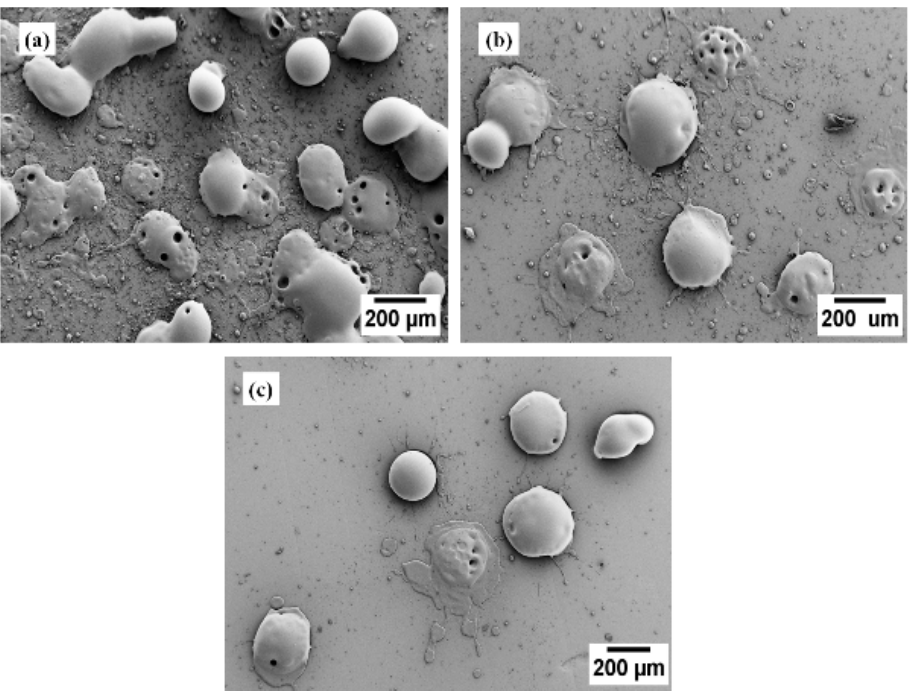
Figure 12. Typical single splats deposited on mild steel substrates ( a ) At 20 cm stand-off distance; ( b ) At 25 cm stand-off distance and ( c ) At 30 cm stand-off